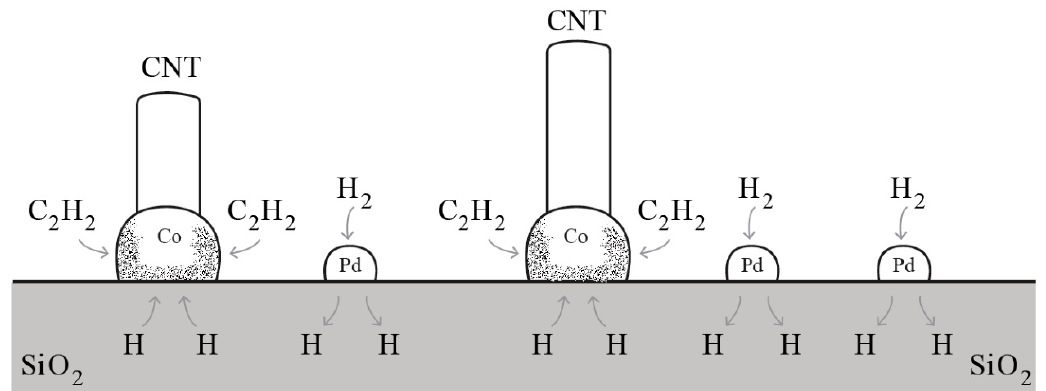
Figure 7. Effect of H 2 splitting by Pd nanoparticles and diffusion of H atoms to the CO particle surface, accelerating the rate of formation of C atoms from C 2 H 2 decomposition and the rate of CNTs